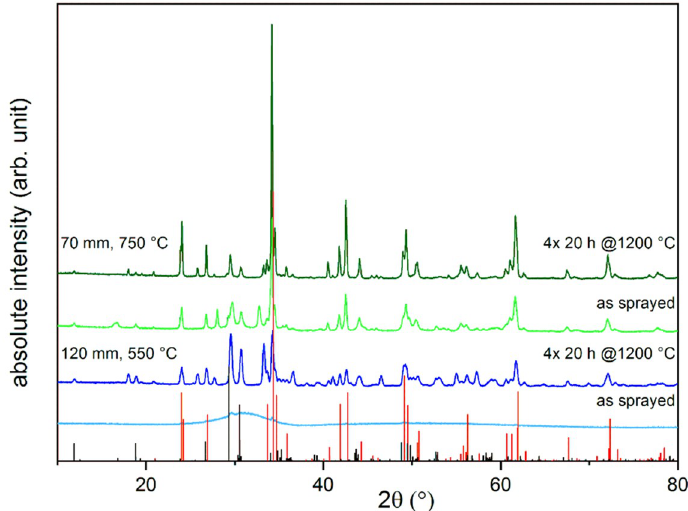
Figure 3. XRD measurements before (light) and after (dark) thermal treatment of APS YAlO 3 coatings; theoretical diffraction patterns of Y 4 Al 2 O 9 (black) and YAlO 3 (red). Table 2. Results of Rietveld refinements of APS YAlO 3